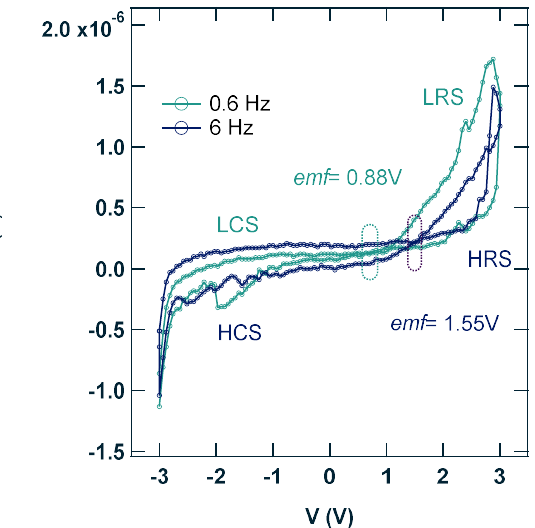
Figure 4. The I vs. V dependence on the scan frequency at 0.6 and 6 Hz of the ITO/ReO 3 @ReS 2 /Al. The sweeping voltage range: ±3 V, and I cc : 1 × 10 −2 A.